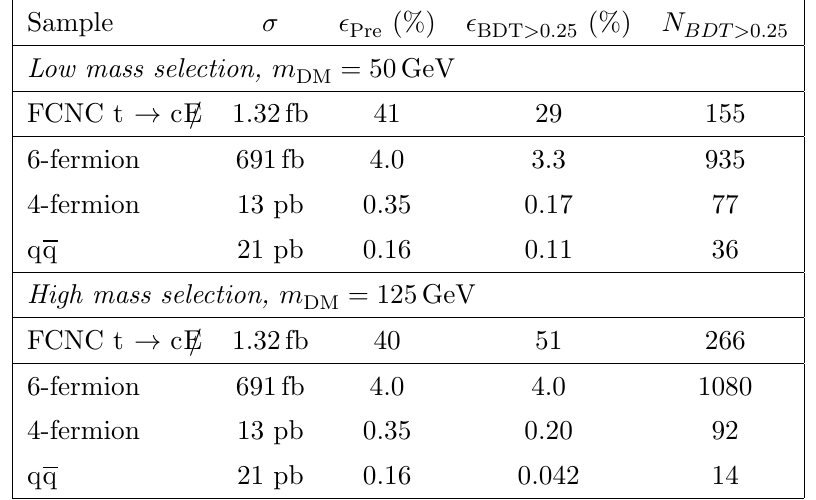
Table 16. Cross section values, selection e(cid:14)ciencies and numbers of events expected for signal and background processes in the analysis searching for FCNC decay t ! cE = at CLIC at 380 GeV. Results are presented for a mass of the invisible scalar particle, m table) and 125 GeV (lower part). Selection e(cid:14)ciencies are quoted for pre-selection ( (cid:15) (cid:12)nal selection of the signal enhanced sample with the BDT response cut, BDT > 0.25. Numbers of events correspond to a luminosity of 1.0 ab (cid:0) 1 with equal amounts of -80% and +80% polarisation running, and BR(t ! cE = ) = 10 (cid:0) 3 for signal events.